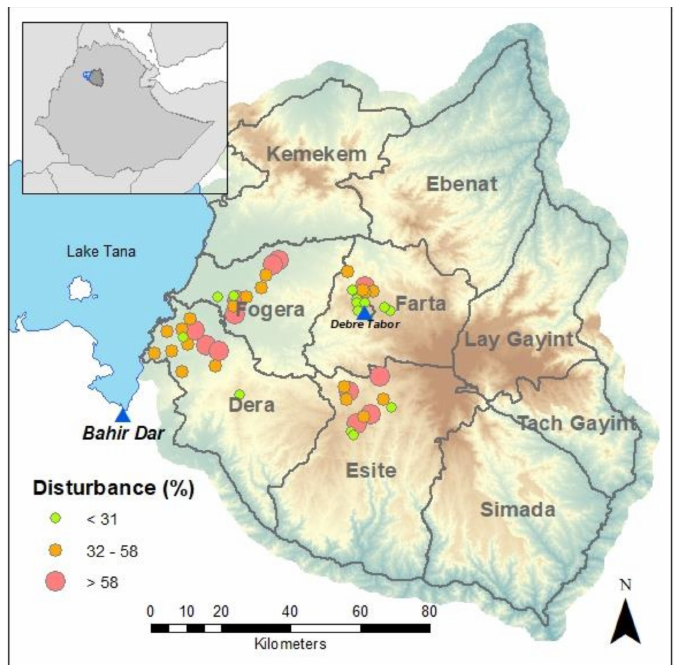
Figure 1. Map of the study area showing the distribution of the 46 church forests across four Woredas and two elevational zones. Forests in the Fogera ( n = 10) and Dera ( n = 12) Woredas were in the Montane elevational zone (1800–2050 a.s.l.). Forests in the Farta ( n = 12), Dera ( n = 1), and Esite ( n = 11) Woredas were in the Upper Montane elevational zone (2400–2800 a.s.l.). The size and color of the dots represent the percent human disturbance (trails, clearings, buildings, and graves): < 31% (small green dots), between 32%–58% (medium orange dots), and > 58% (large pink dots). Basemap images obtained from